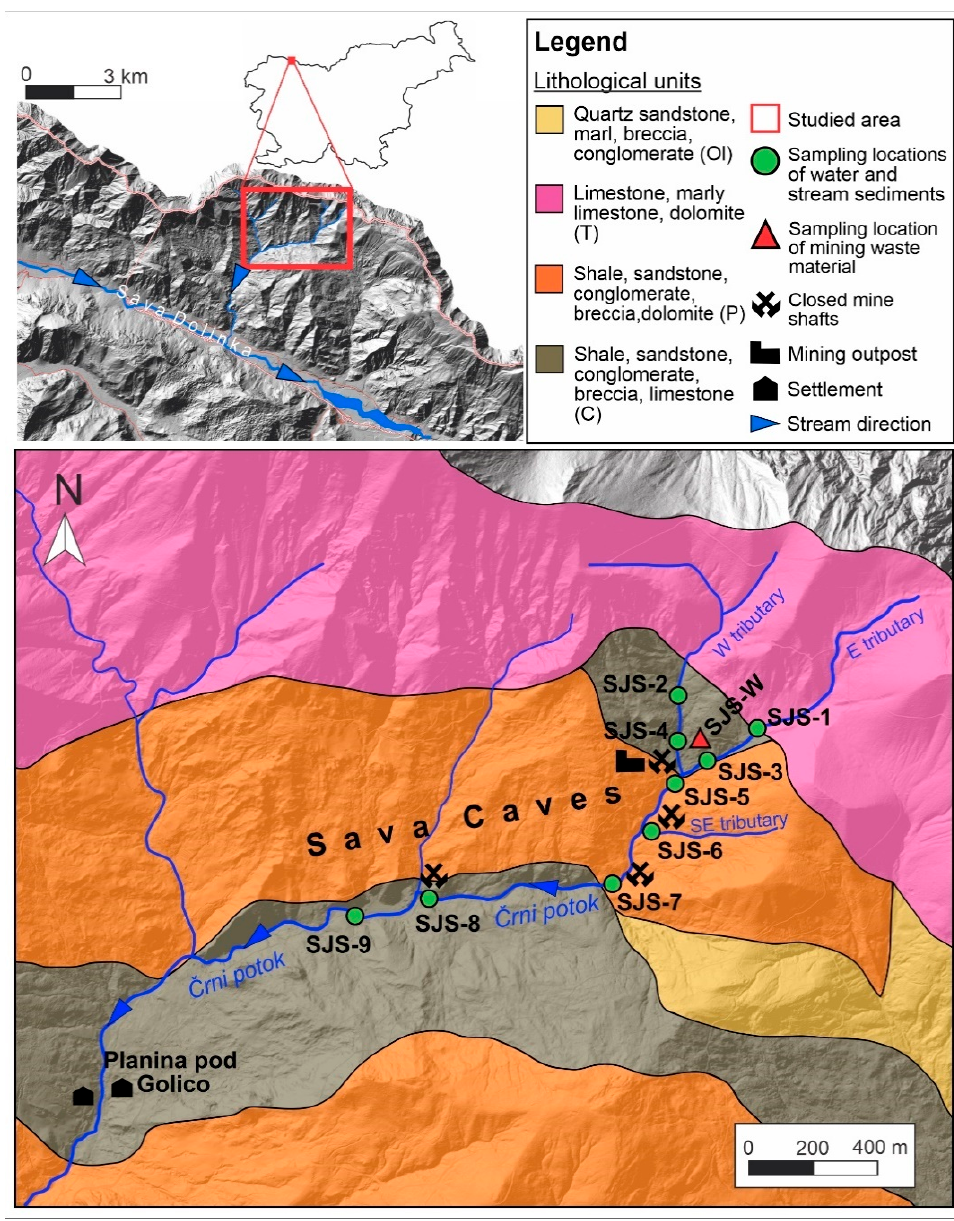
Figure 1. A topographic map with generalized lithology of Oligocene (Ol), Triassic (T), Permian (P), and Carboniferous (C) rocks [28]. Sampling locations of samples SJS-W (mine waste) and SJS-1 to SJS-9 (stream sediment), closed mine shafts, mining outposts, and mine waste in the area of the Sava Caves are presented on the map.